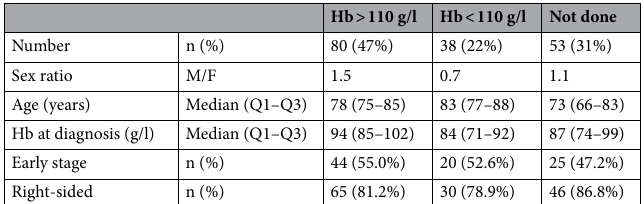
Hb > 110 g/l Hb < 110 g/l Not